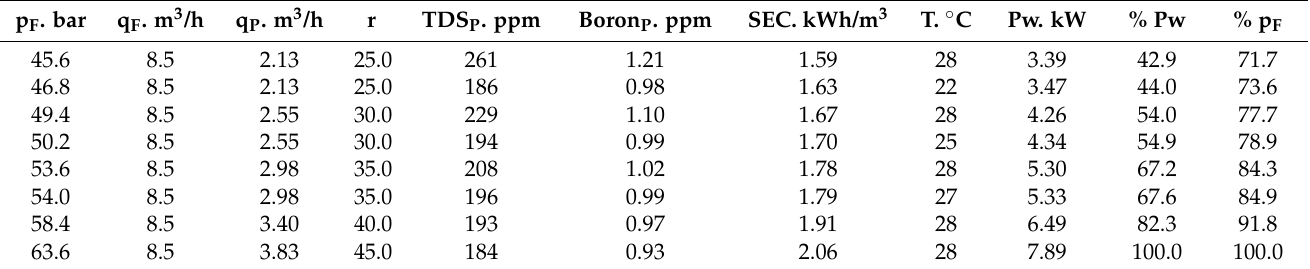
Table 4. Working conditions of a single pressure vessel with seven LG SW 440 SR membrane elements operated at a constant feed flow under Mediterranean conditions at an unfavorable